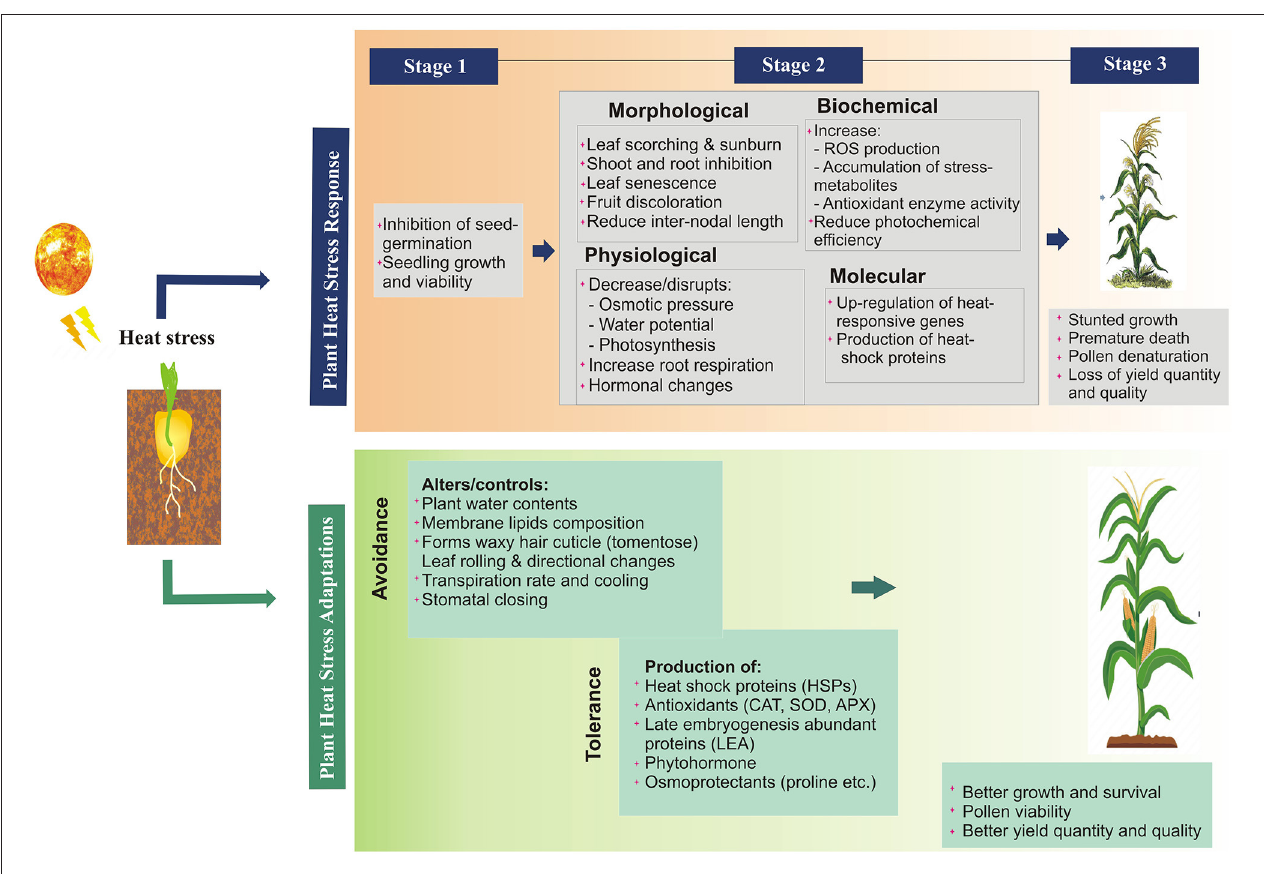
FIGURE 2 | Heat stress responses and adaptation mechanisms in plants at different